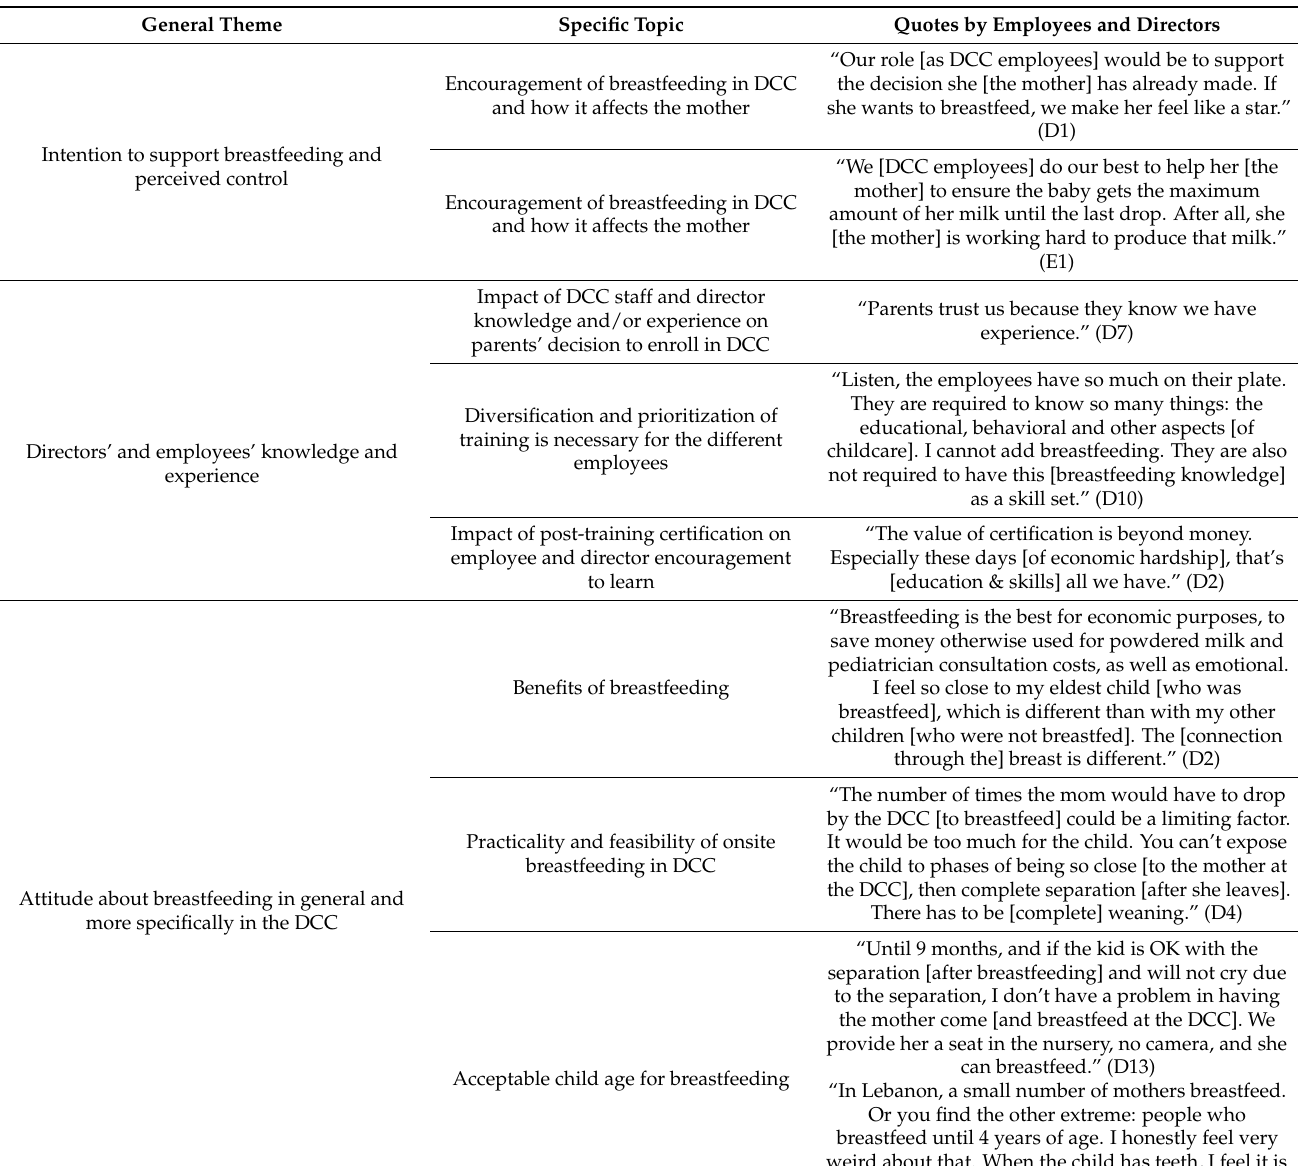
Table 3. Table of